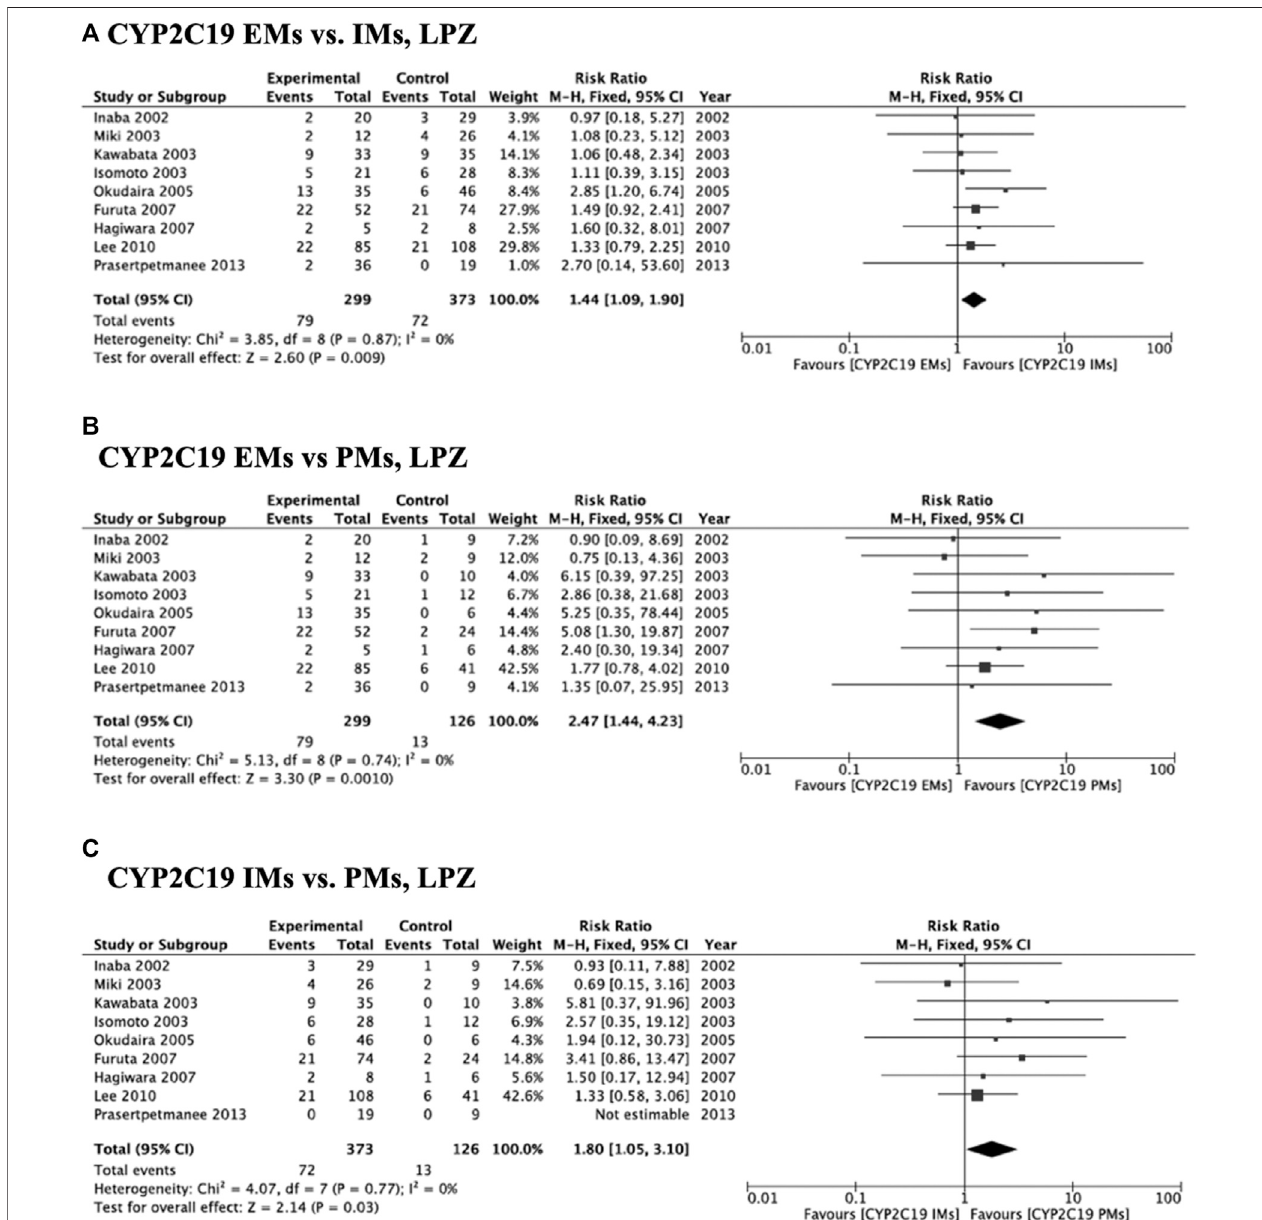
FIGURE 3 | Forest plots of H. pylori cure rates of LPZ-amoxicillin-clarithromycin regimen among different CYP2C19 genotypes in the fi xed-effects model. (A) CYP2C19 EMs vs IMs, (B) EMs vs PMs and (C) IMs and PMs.; Abbreviations: CI, con fi dence interval; EM, extensive metabolizer of CYP2C19; IM, intermediate metabolizer of CYP2C19; LPZ, lansoprazole; PPI, proton pump inhibitor; PM, poor metabolizer of CYP2C19; PPI, proton pump inhibitor.